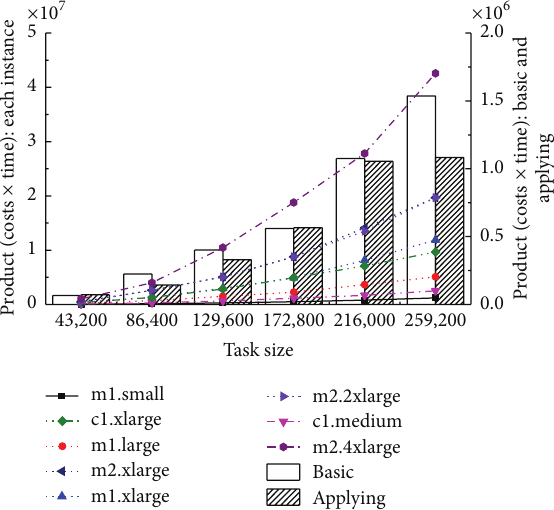
Figure 8: Comparison of combined metrics (total task execution time and